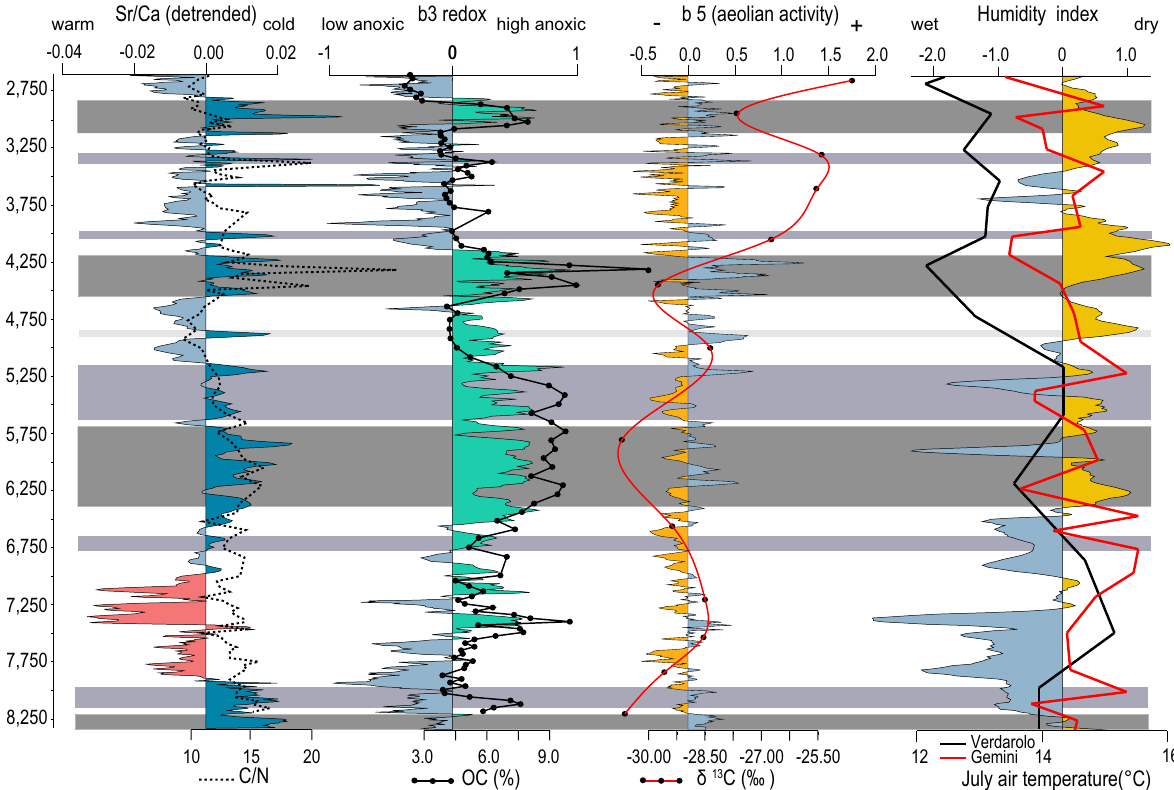
Figure 4. Sr/Ca (3-point average curve) balances b3 (redox) and b5 (aeolian input) derived from the XRF data and its connection with organic matter data (C/N, OC and δ 13 C). Gray bands indicate the main cold events, and purple bands are minor cold events recognized in M1-A. The correlation of those events with temperature changes in Lakes Gemini and Verdarolo and the humidity index from Corchia are visible on the right side of the